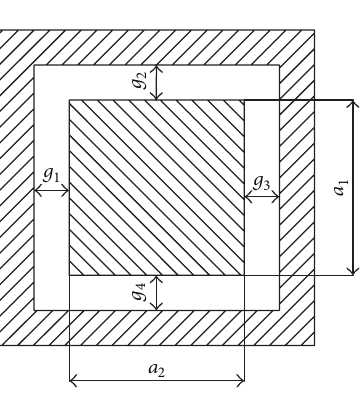
Figure 3: Fluid added